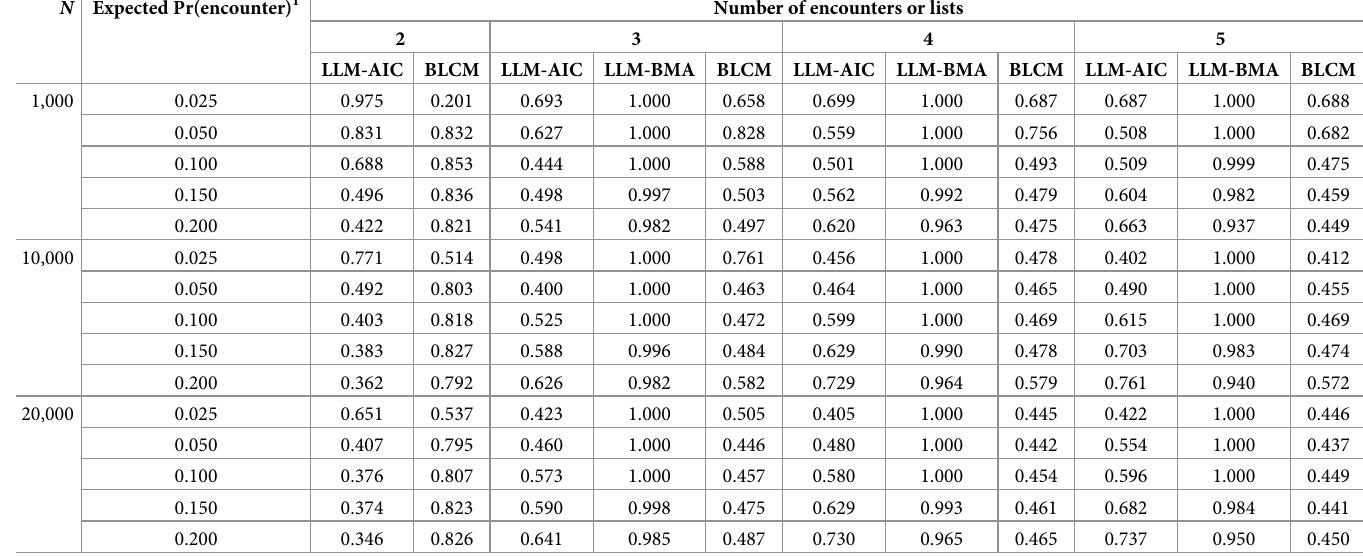
Table 3. Coverage of uncertainty intervals (95% confiddence intervals for loglinear model selection LLM-AIC, and Pr = 0.95) credible intervals for Bayesian model averaging LLM-BMA and latent-class modeling BLCM). N Expected Pr(encounter)